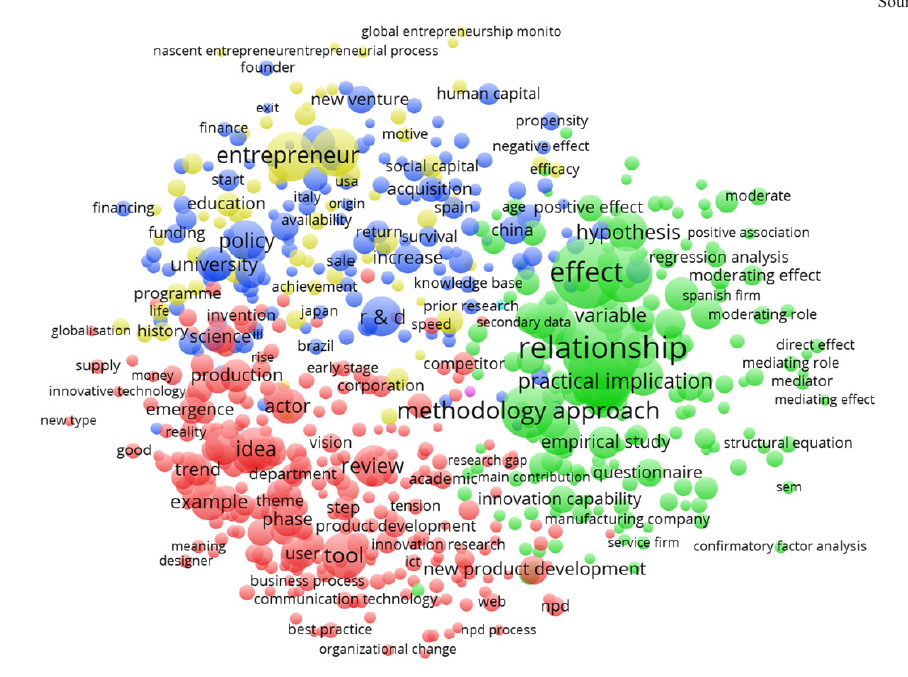
Figure 1. Knowledge map for the innovation management by